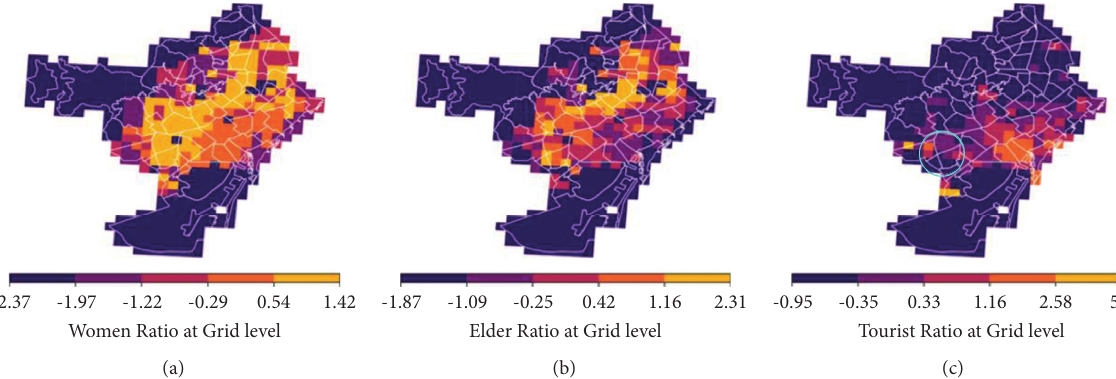
Figure 4: Heatmap of tendency to receive visitors of three types in the city: women, elderly, and tourists. Inside the blue circle: the Camp Nou area. (a) Women ratio at grid level. (b) Elder ratio at grid level. (c) Tourist ratio at grid